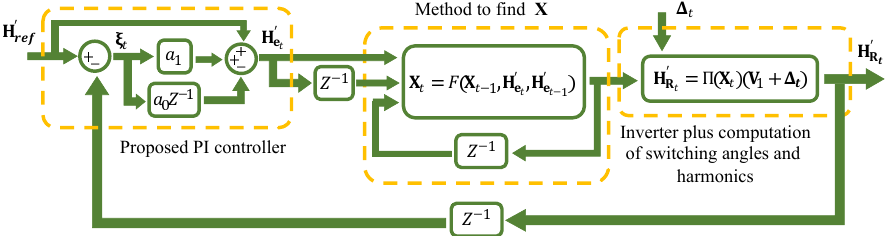
Figure 8. Block diagram of the CFBMI with the solving method of the Groebner basis conversion, the PI controller and the acquisition of the harmonics.